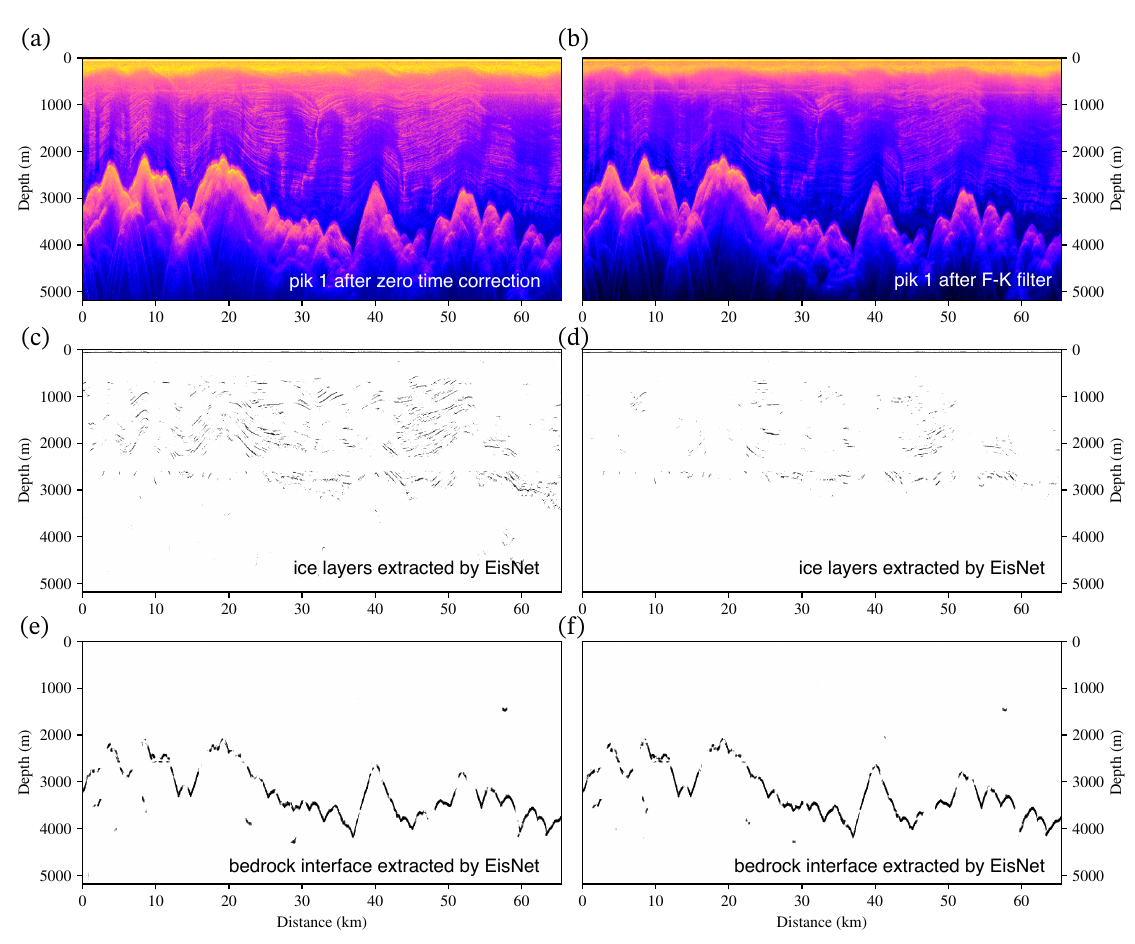
Figure 7. Comparison of EisNet extractions before and after KL filtering from Line 1 (TSH data). ( a ) The raw input radar image. ( b ) The inputted radar image after KL filtering as a preprocess. ( c ) The extracted feature of internal layers without KL filtering. ( d ) The extracted feature of internal layers from radar image after KL filtering as a preprocess. ( e ) The extracted feature of the bedrock without F–K filtering. ( f ) The extracted feature of the bedrock from the radar image after KL filtering as a